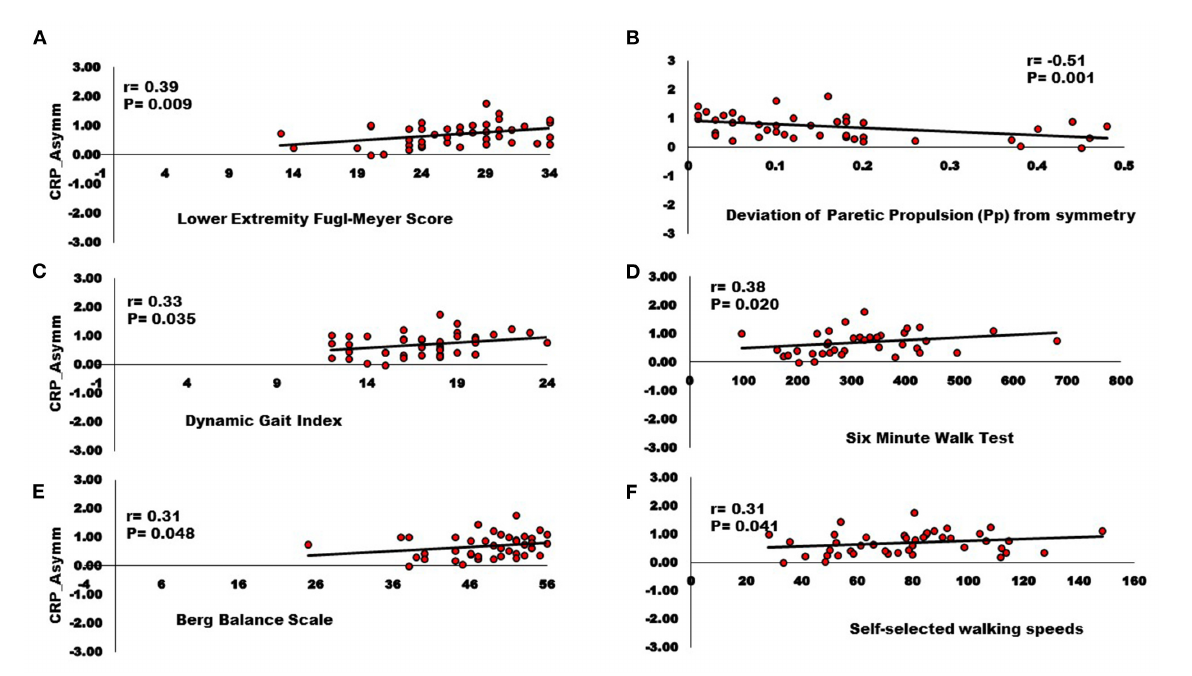
FIGURE4 Relationships between Inter-hemispheric asymmetry of CRP streamlines and (A) Lower extremity Fugl-Meyer score; (B) Deviation of paretic propulsion (Pp) from symmetry; (C) Dynamic gait index; (D) Six-minute walk test; (E) Berg balance scale; (F) Self-selected walking speed. The Asymm Stroke for CRP (i.e., fewer CRP streamlines on the lesioned hemisphere) were positively correlated with Lower extremity Fugl-Meyer score, Dynamic gait index, Six-minute walk test, Berg balance scale, Self-selected walking speeds, and negatively correlated with deviation from symmetric Pp ( p < 0.05).